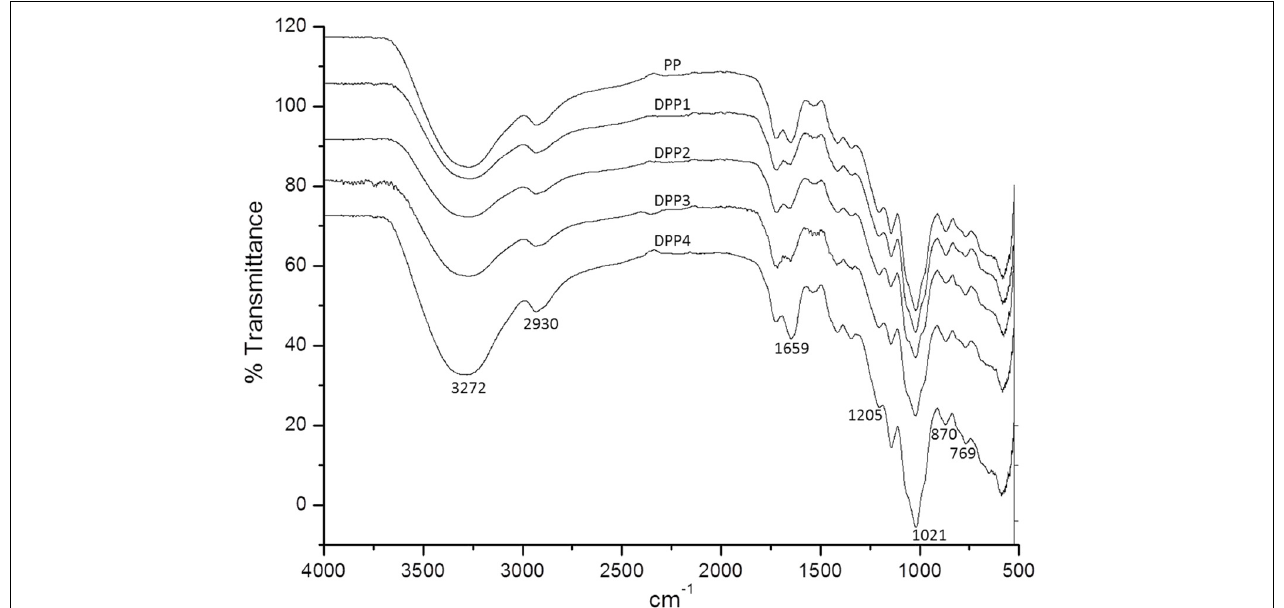
FIGURE 1 | FT-IR spectra of four degraded (DPP1,2,3,4) and natural polysaccharides (PP) from P. yezoensis .